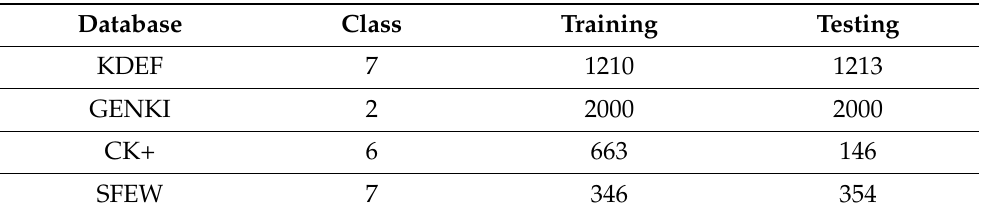
Table 4. Presentation of the employed facial expression